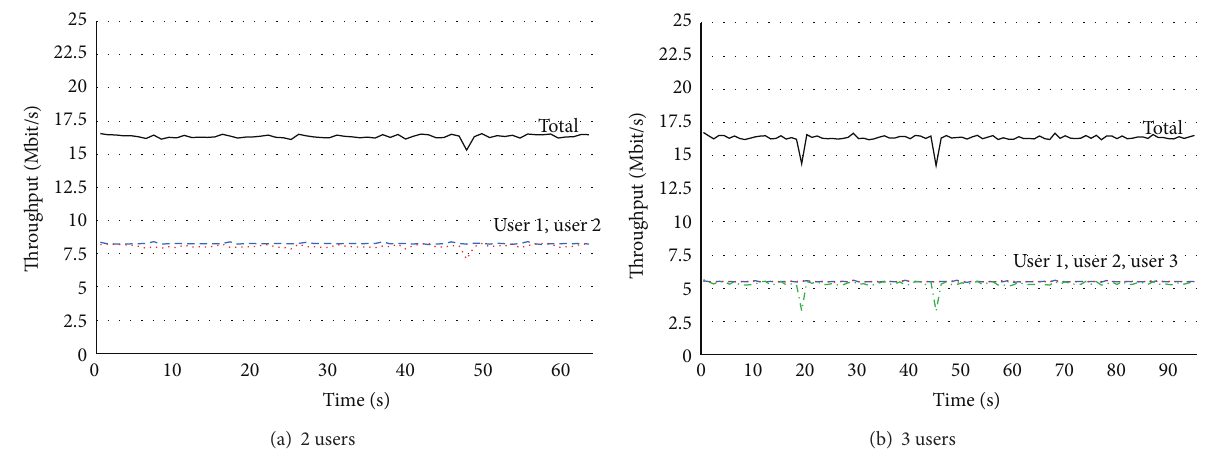
Figure 5: Basic throughput performance with Matrix A mode.